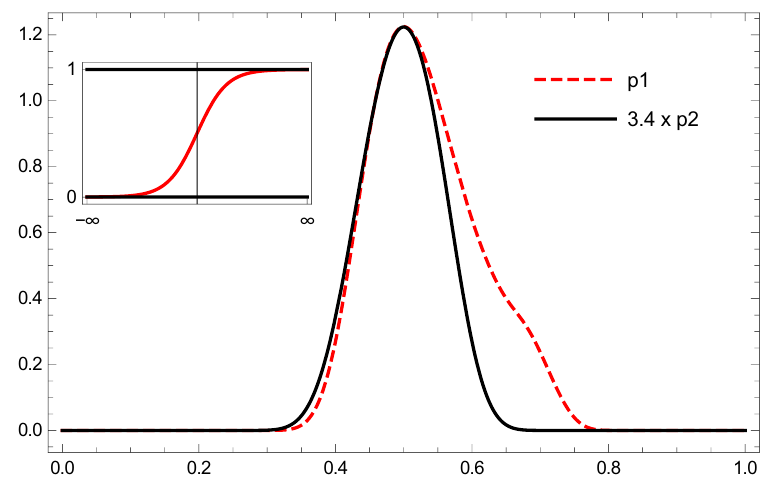
Figure 4: Boltzmann factor exp ( − Re ( S )) vs. flow parameter τ on the contributing thimbles in the z 4 model. The integration ranges have been mapped to [ 0,1 ] and the transformation is shown in the inlay, for details see App. B. Here we choose the free parameter in the transformation (25) to be ξ =